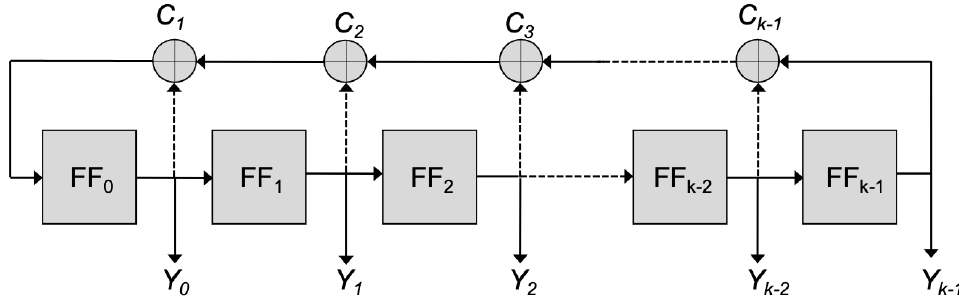
Figure 2. Schematic representation of an ALFSR. It is realized by k D-flip-flop (FF 0 ÷ FF k − 1 ) and a feedback path where some XOR C i may be present. The feedback function depends on the presence/absence of the XOR (at least one must be present). Preset signals for register initialization are not shown. The autonomous property indicates that no input is present, so that once initialized in any state but all zeros, the cycling diagrams depend only on the feedback function.